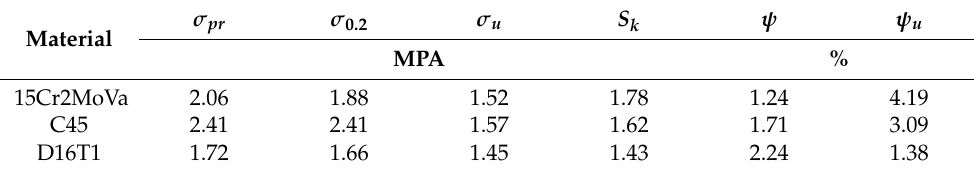
Table 6. K values of relative measures of the key mechanical